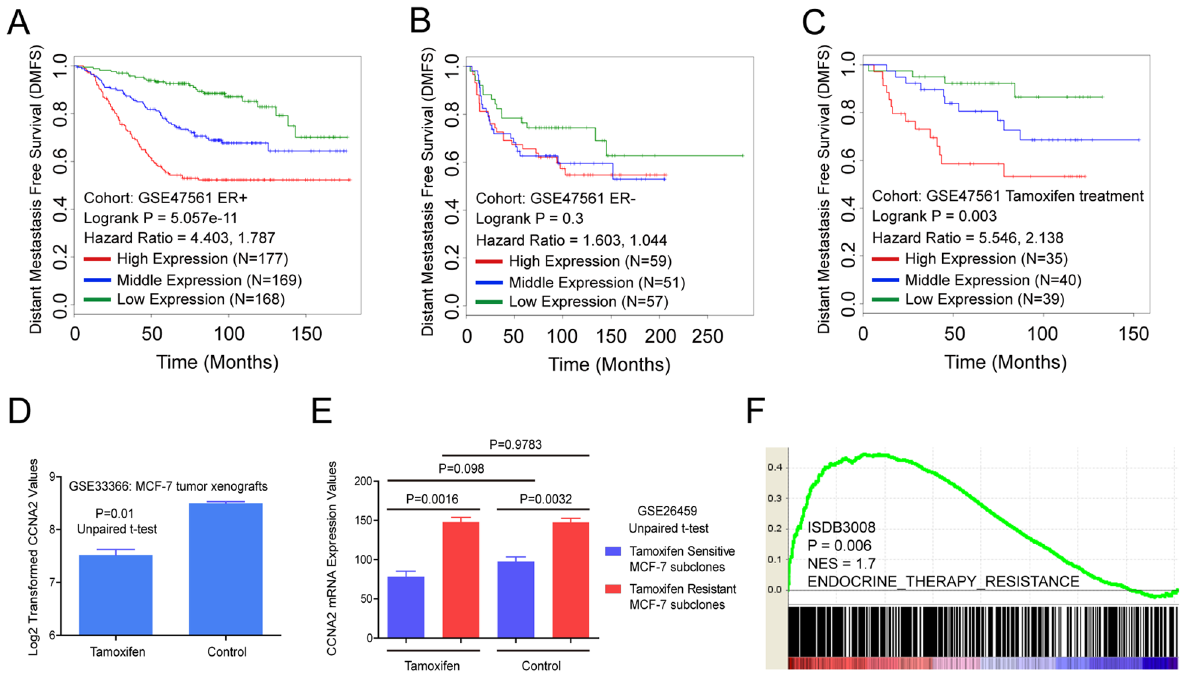
Figure 1. CCNA2 expression is associated with poor survival and tamoxifen resistance in ER + breast cancer patients. Kaplan-Meier plot for DMFS of ER + ( A ), ER- ( B ) or tamoxifen treated ( C ) breast cancer patients grouped by the tertile of CCNA2 expression levels, significance was assessed by logrank test. ( D ) Log2 transformed mRNA expression values of CCNA2 in MCF-7 tumor xenografts treated with either tamoxifen or control. P values were calculated by unpaired two-tailed t test. Error bars represent mean 6 SEM. ( E ) mRNA expression values of CCNA2 in tamoxifen resistant/sensitive MCF-7 subclones treated with tamoxifen or control. P values were calculated by unpaired two-tailed t test. Error bars represent mean 6 SEM. ( F ) Gene set enrichment analysis of CCNA2 mRNA expression in relation to tamoxifen resistance gene set using breast cancer